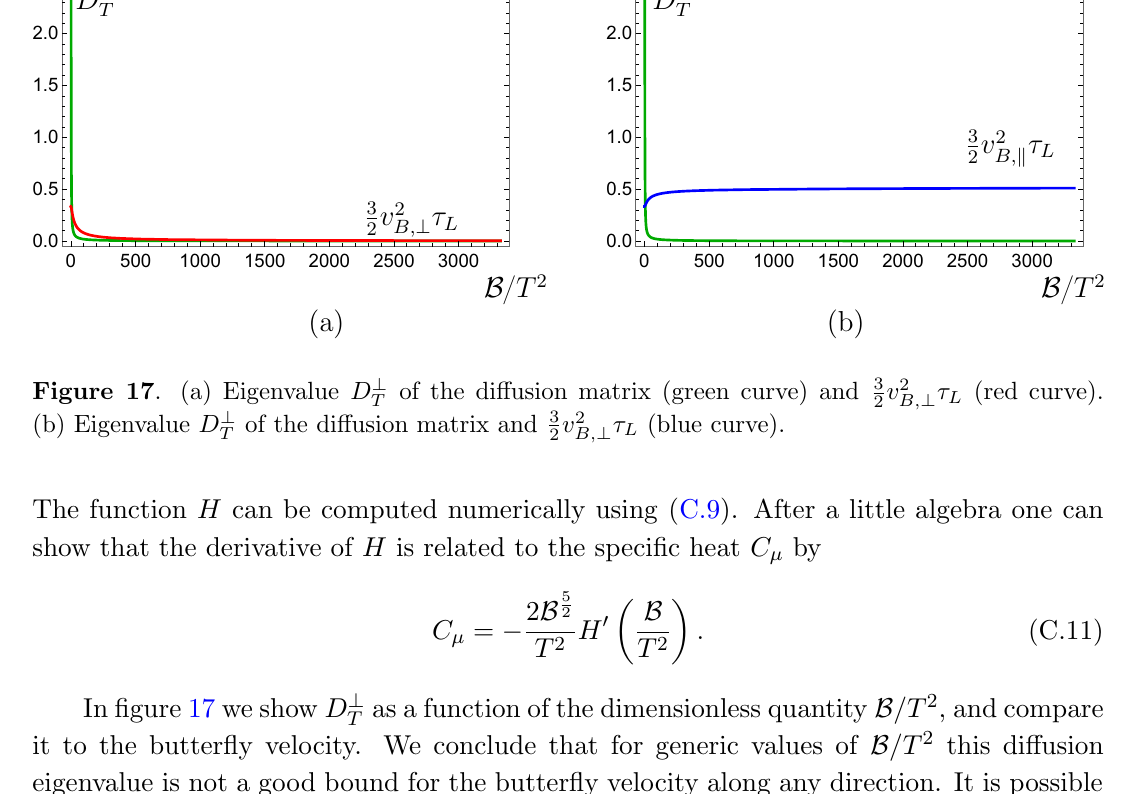
v 2 (cid:28) L (blue B; ? 2